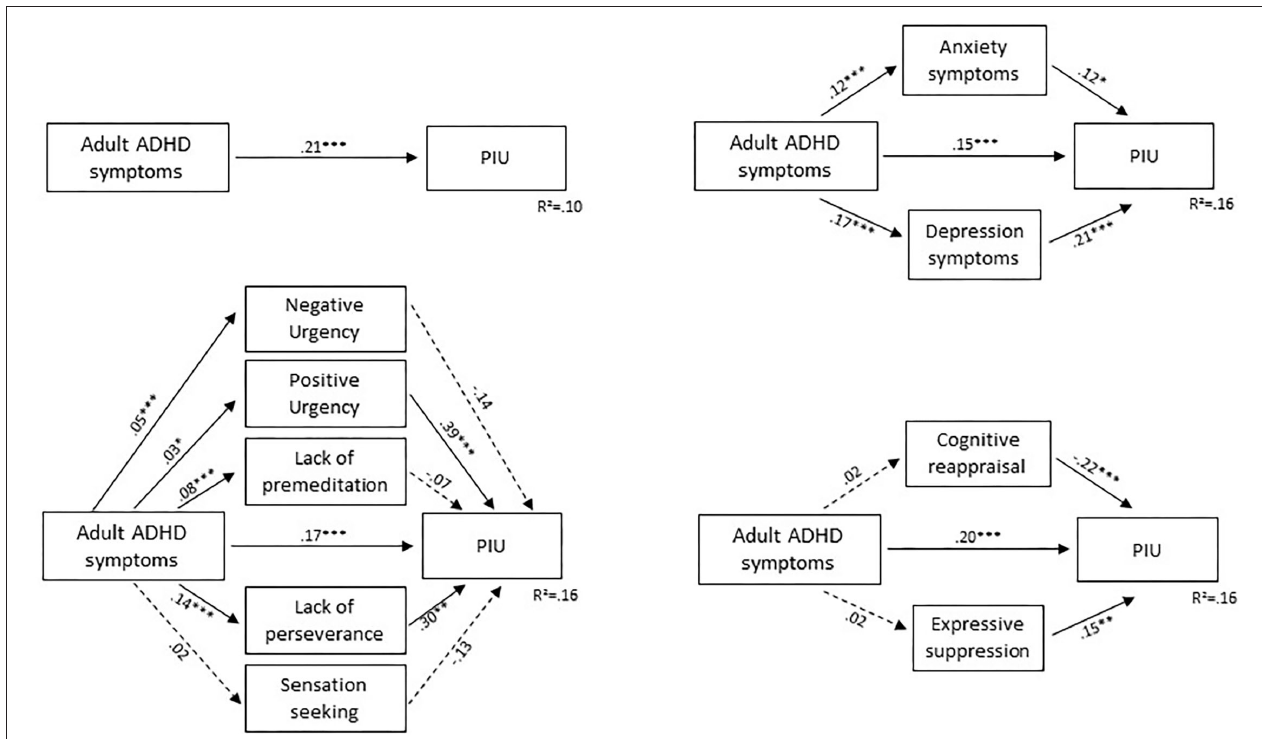
FIGURE 1 | Mediation models of the association between adult ADHD symptoms and PIU. Unstandardized coefficient; * p < 0.05, ** p < 0.1, *** p < 0.001; PIU, problematic internet use assessed by the Internet Addiction Test; Non-continuous arrow, non-significant effect; continuous arrow, significant effect.